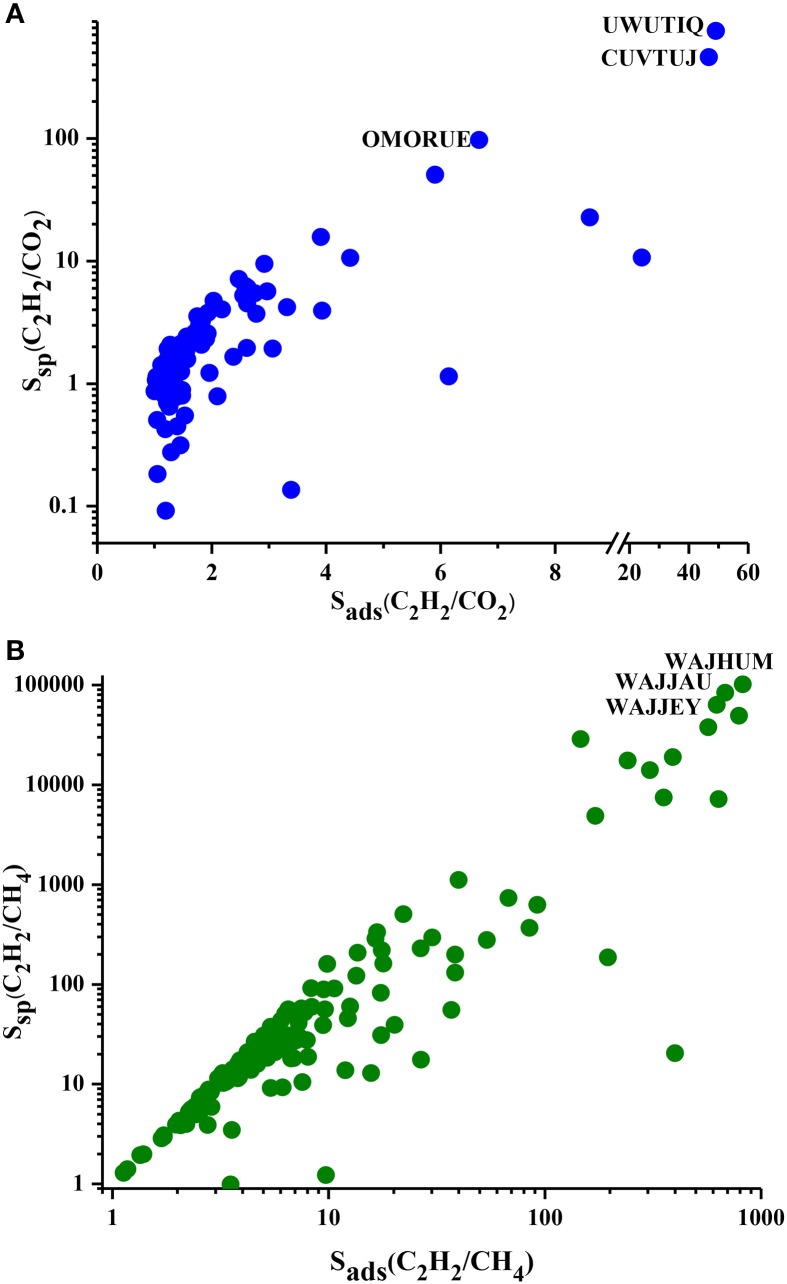
Ssp and Sads of MOFs for (A) C2H2/CO2 and (B) C2H2/CH4 separations.